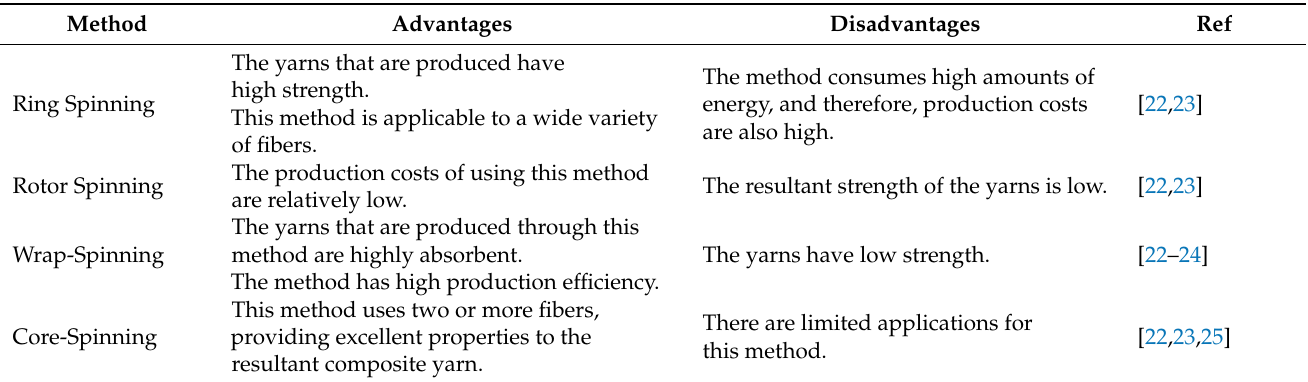
Table 1. The advantages and disadvantages of different spinning